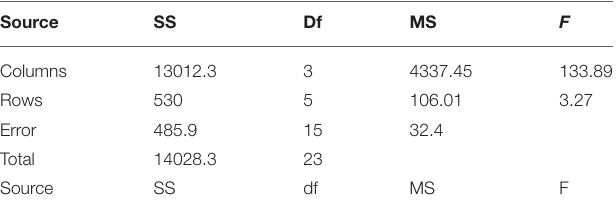
TABLE 3 | ANOVA for the effect of silver nanogel on excision wound model in albino Wistar rats.